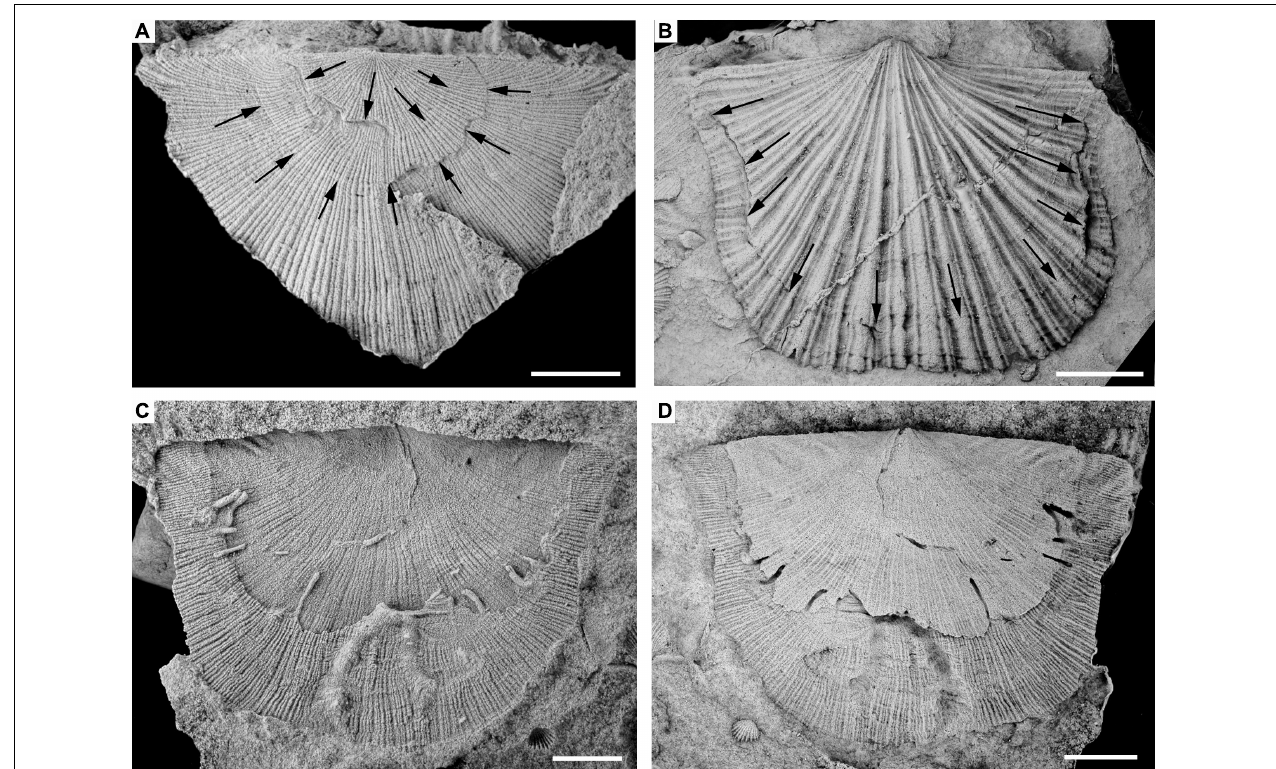
FIGURE 4 | (A–D) Valves of three brachiopod species recorded in the assemblage with repaired broken margins (all scale bars = 5 mm). (A) Latex cast of exterior of dorsal valve of Heterorthis retrorsistria with two successive repaired broken margins (CPI 6577). (B) Latex cast of exterior of ventral valve of Horderleyella chacaltanai with repaired broken margin (CPI 6553). (C,D) External mould and latex cast of exterior of ventral valve of Colaptomena expansa with Palaeosabella borings arranged on repaired broken margin (CPI-6507a).